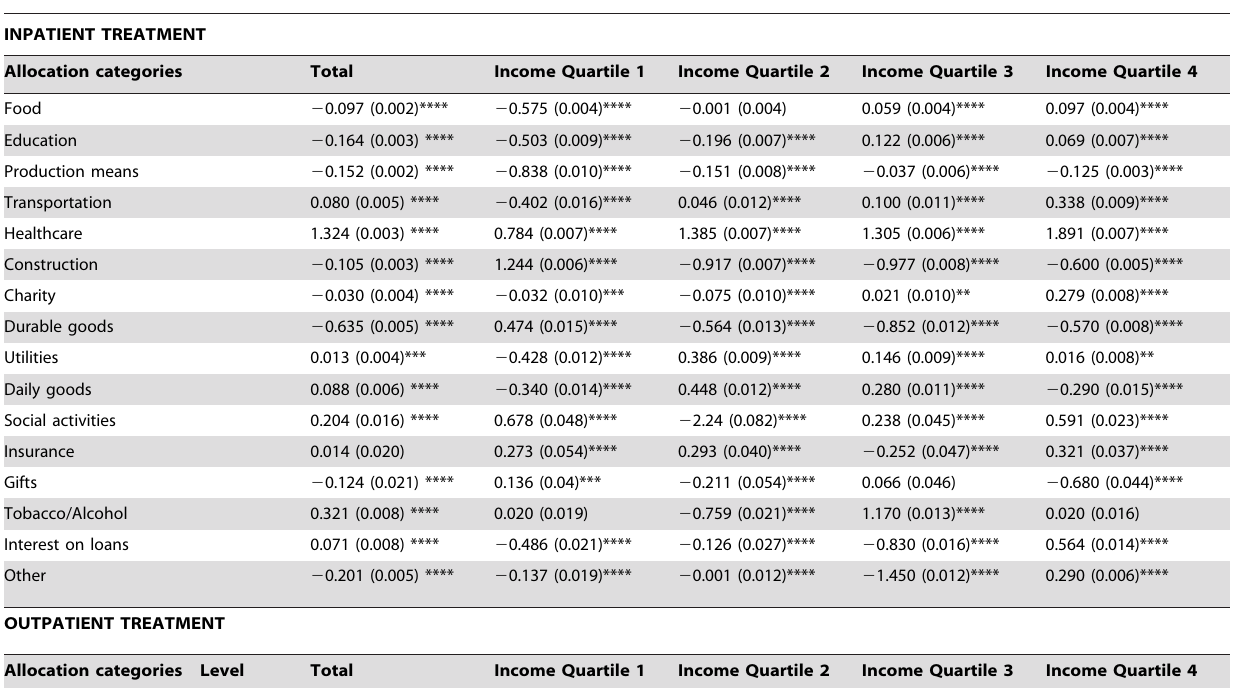
Table 4. Results of multivariate regression analyses of inpatient and outpatient treatment and percentage of household allocation